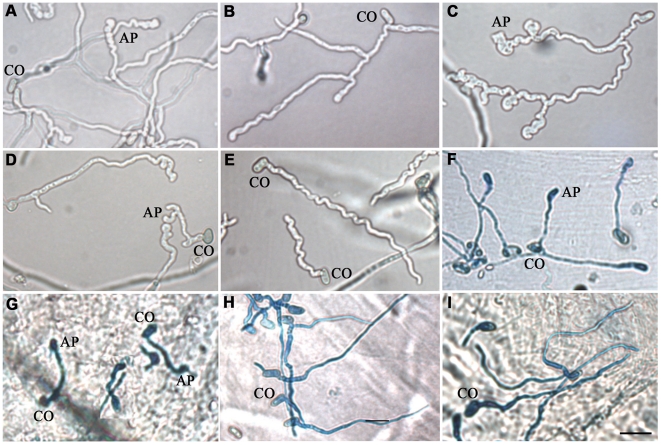
MEST1 regulates appressorial differentiation.Growth of (A) wild type Metarhizium robertsii Mr2575, (B) mutant ΔMest1, (C) over-expressing strain Mr2575-gpd::Mest1, (D) transgenic strain Ma324-Mest1, and (E) wild type Metarhizium acridum Ma324 in YE+Manduca sexta cuticular lipids. Appressoria formed by transgenic strain Ma324-Mest1 on (F) Galleria mellonella and (G) M. sexta cuticles compared to differentiation of wild type Ma324 on (H) G. mellonella and (I) M. sexta cuticles 24 h post inoculation. CO, conidia; AP, appressorium. Bar, 10 µm. The fungal hyphae and infection structure were stained by Lactophenol Cotton Blue stain.